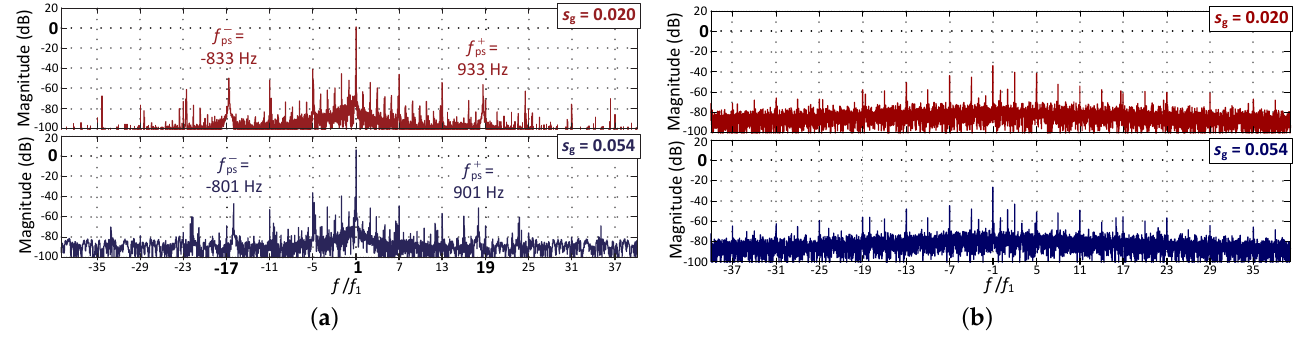
Figure 21. Complex spectrum of stator current for six-phase IM with symmetrical SWA, one pole pair and 18 rotor slots [202]. In the label of the horizontal axis, f represents any frequency and f 1 the fundamental frequency. ( a ) α 1 - β 1 plane. ( b ) α 2 - β 2 (i.e., x - y ) plane.